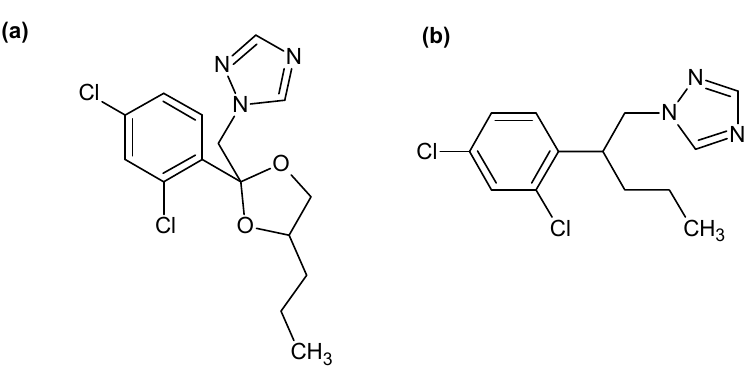
Figure 2. The structures of the Pd(II) extractants investigated by Anpilogova et al. [30]: ( a ) propiconazole and ( b ) penconazole.